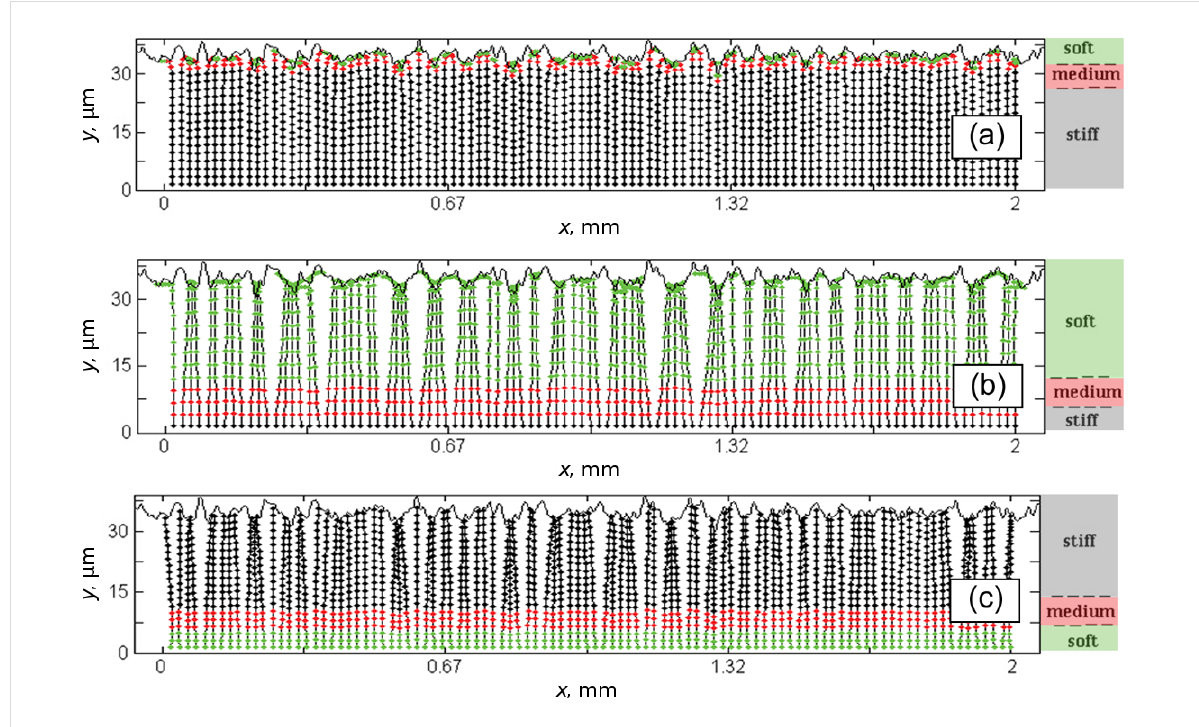
Figure 2: Typical configurations of the filamentary structure (setal array) attached to the stiff support (below) in adhesive contact with random fractal surface (above). This numerical model was used to mimic biological setal arrays shown in Figure 1. Three types of fibers, (1) stiff fibers with short elastic ends, (2) long elastic fibers connected to the base by short stiff roots, and (3) stiff fibers with soft elastic segments near the base are shown in subplots (a), (b) and (c), respectively. Different stiffness of segments is conditionally shown by circles with different colours. Stiff, medium and soft segments are marked by black, red and green circles,